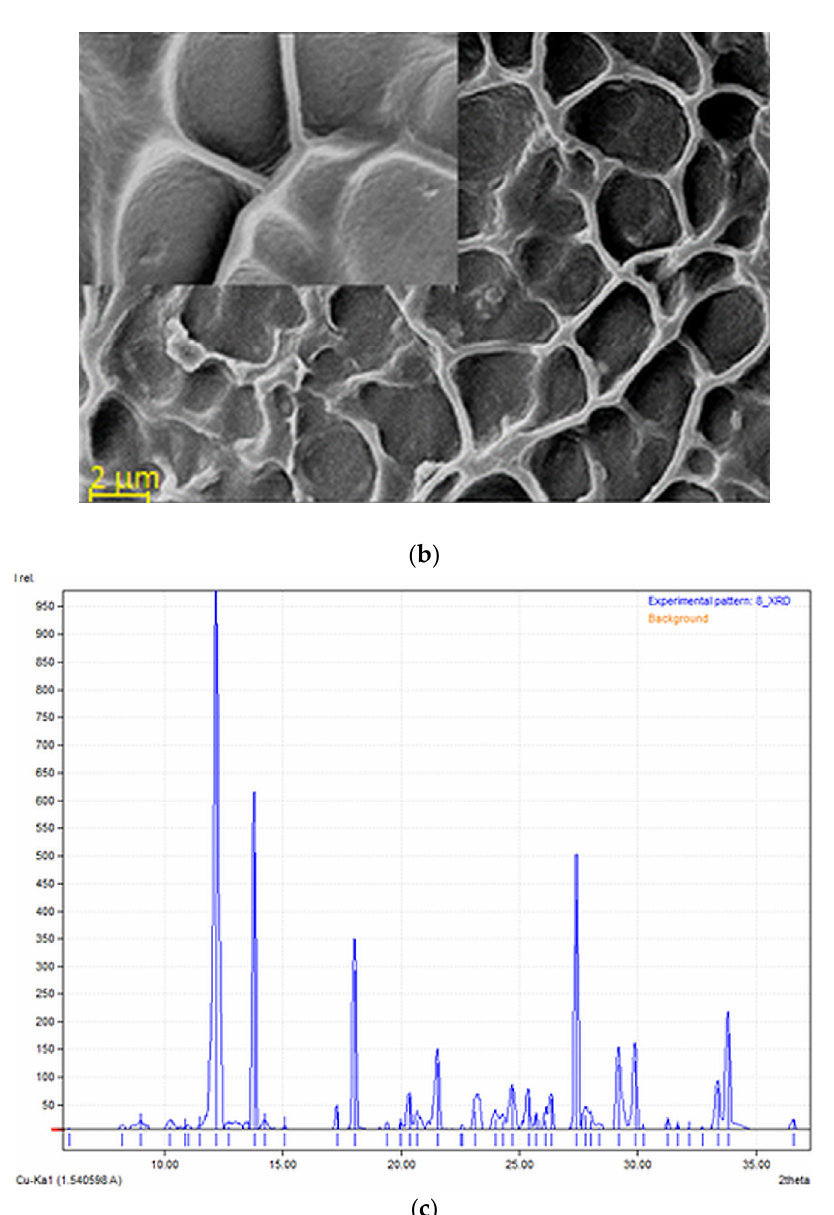
Figure 5. ( a ) Fluorescence microscopy image of the complex mixture of active formulations in HA hydrogel. ( b ) SEM image with included detail of the specific structure for the complex mixture; ( c ) X-ray diffraction pattern of HA-MEL-MZ-T mixture.